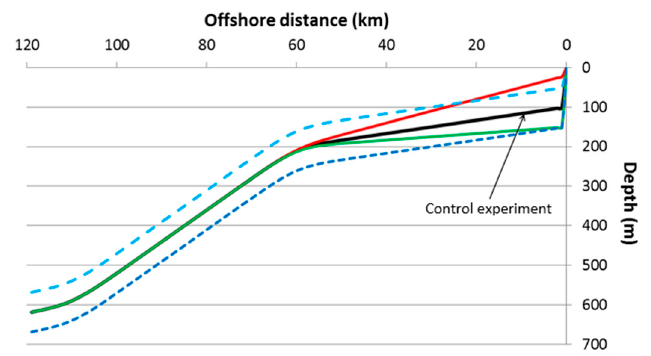
Figure 2. Variations of ambient bathymetry (m) considered in sensitivity experiments.